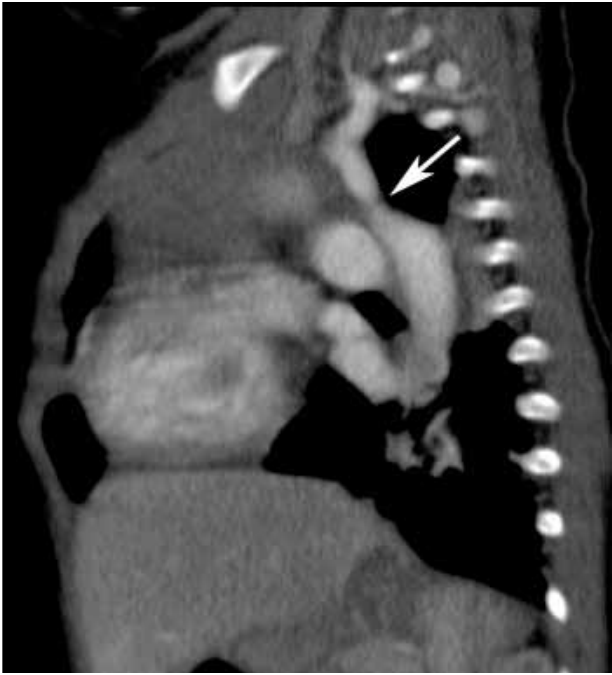
Fig. 5. Oblique sagittal MIP image showing the aortic coarctation